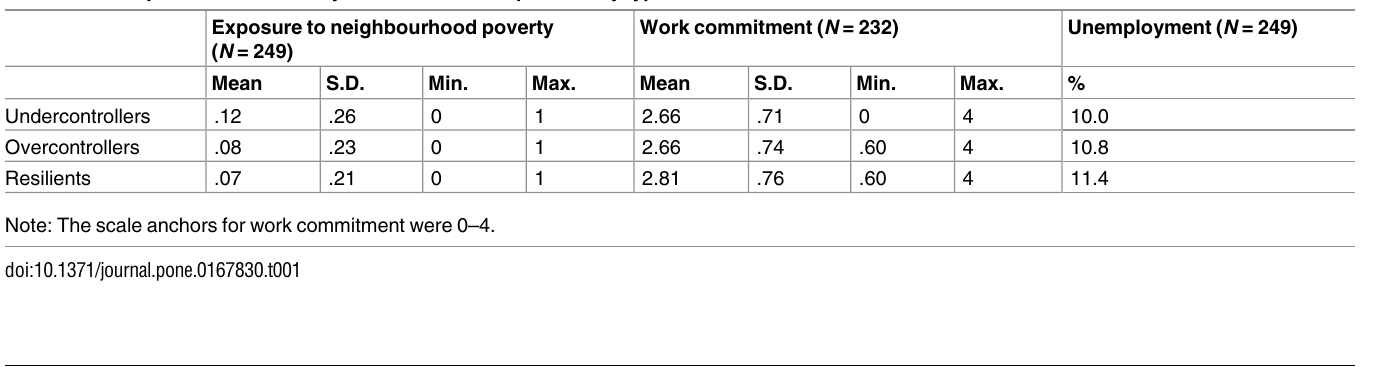
Table 1. Descriptivestatistics of key variables for each personality